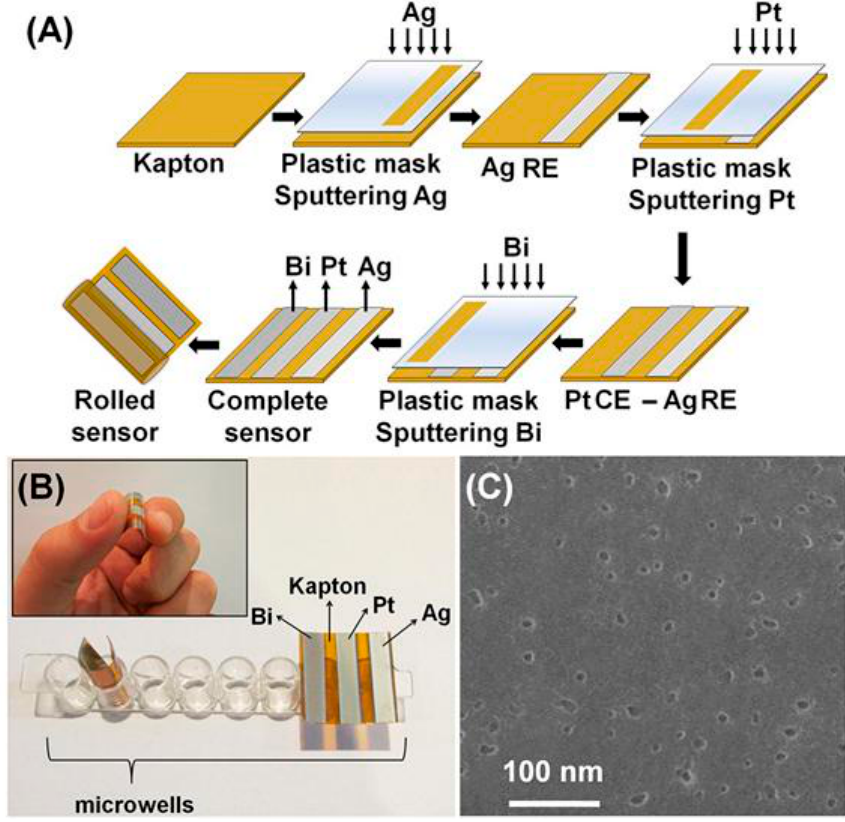
Figure 5. ( A ) The fabrication steps of a flexible bismuth sensor on polyimide substrate through sputtering deposition process. ( B ) Photographs of the sensors. ( C ) A field emission scanning electron microscope image of streptavidin-modified PbS QDs. Reproduced from [54], with permission from American Chemical Society, 2019.